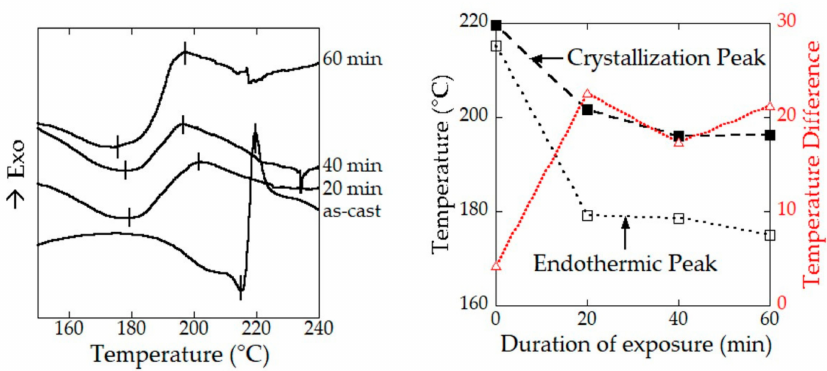
Figure 7. DSC β -sheet crystallization peaks of the S. c. ricini LF aq film treated with HFIP gas at 23 ◦ C for 20, 40, and 60 min. The panel on the right is a plot of the β - sheet crystallization peak temperatures against the duration of exposure to HFIP gas.